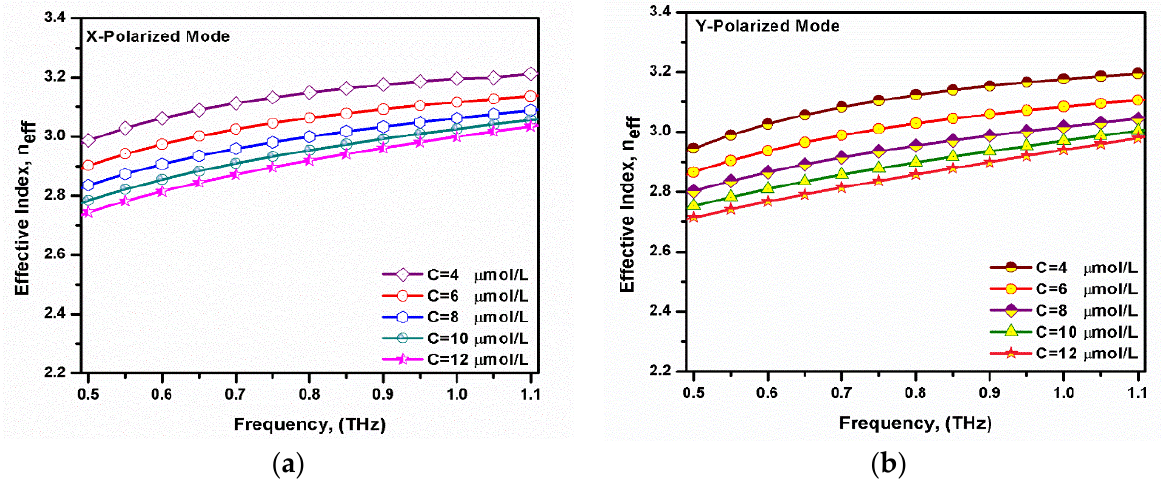
Figure 4. Variation of the frequency-dependent effective index of the fundamental ( a ) x-polarized mode and ( b ) y-polarized mode at different bilirubin concentrations.